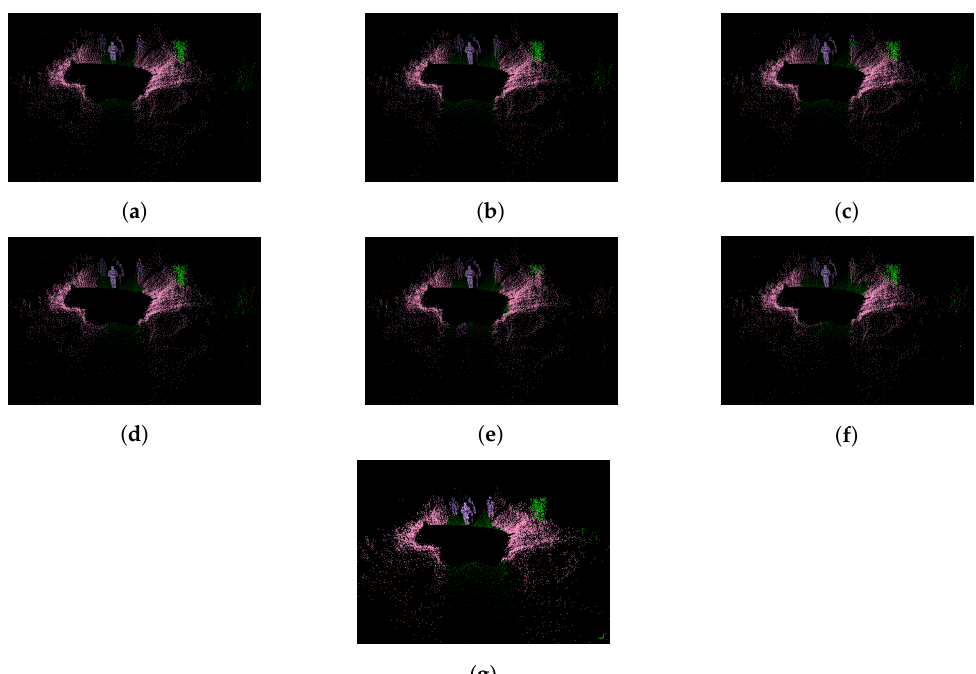
Figure 9. Semantic segmentation results of the RELLIS-3D dataset are presented as point clouds. ( a ) Ground Truth; ( b ) SegUNet3D; ( c ) SegNet; ( d ) U-Net; ( e ) SqueezeSegV2; ( f ) PointSeg; ( g )